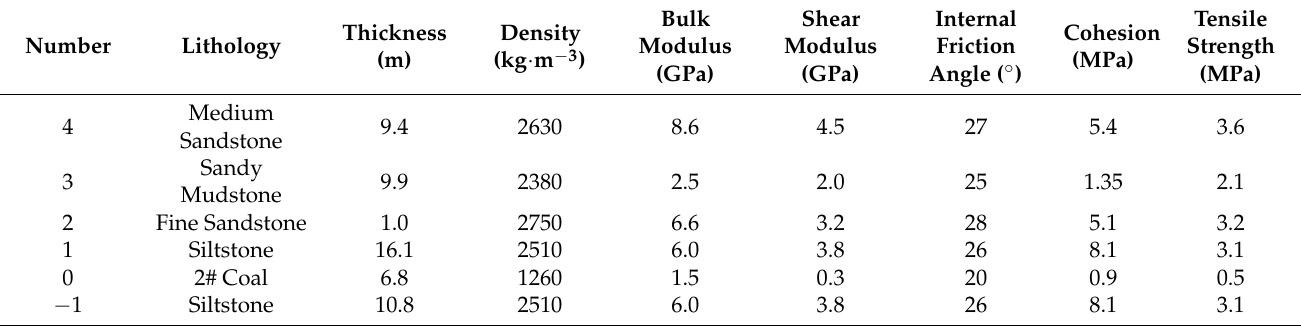
Table 2. Rock mass mechanical parameters of each rock stratum in the numerical